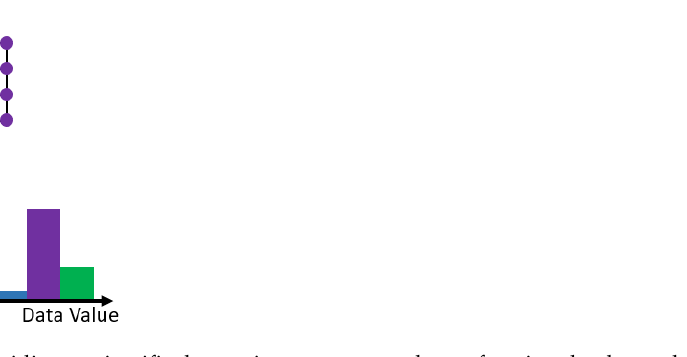
Figure 3. An example of dividing a scientific dataset into two sets and transforming the data values in each set into a histogram.